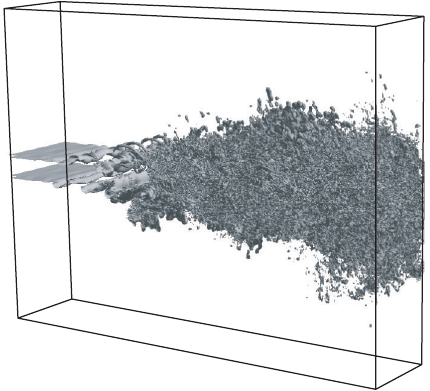
Figure 1: An instantaneous isosurface of the vorticity magnitude, |𝜔| = 3 , at time 𝑡 ⋆ = 100 .